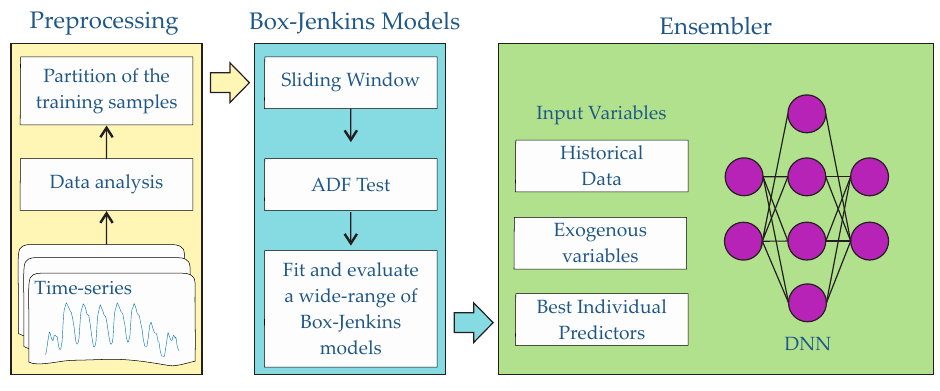
Figure 2. Proposed methodology: